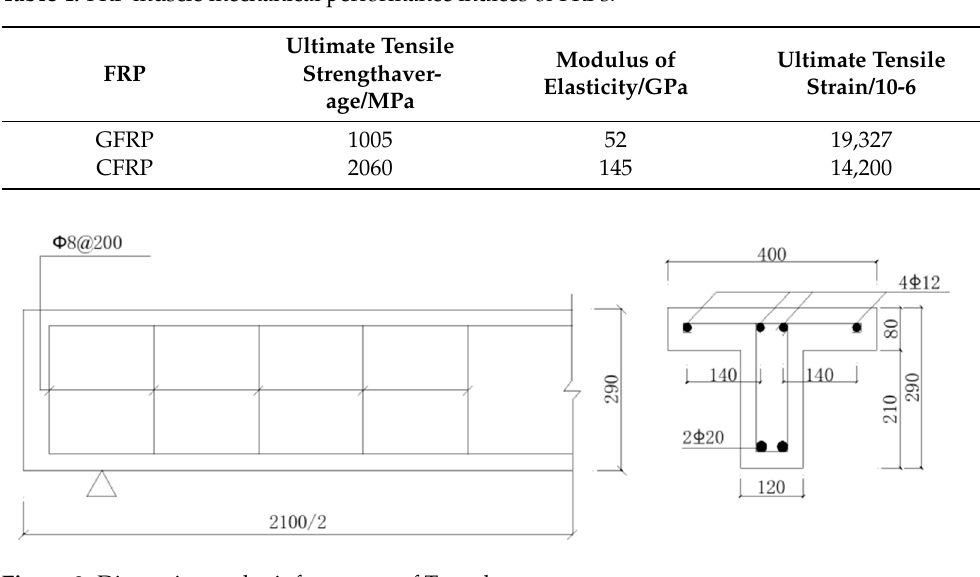
Figure 3. Dimension and reinforcement of T test beam.